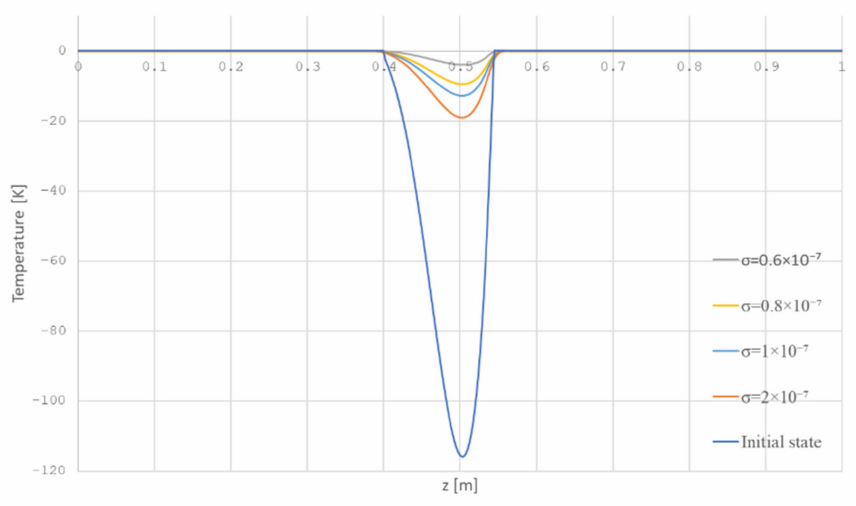
Figure 12. The dependence of the control price on temperature at time τ